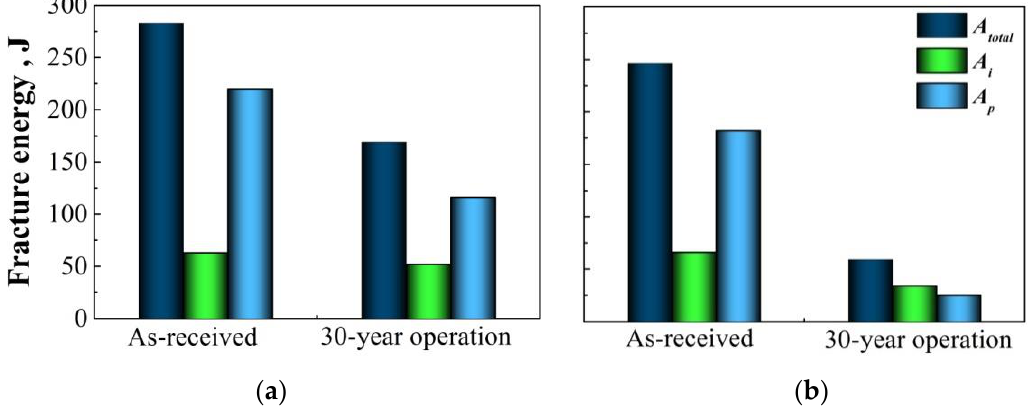
Figure 1. Total fracture energy A total and its components of crack initiation A i and crack propagation A p during Charpy tests of X52 pipe steel at ambient ( a ) and − 20 ◦ C ( b ) temperatures.